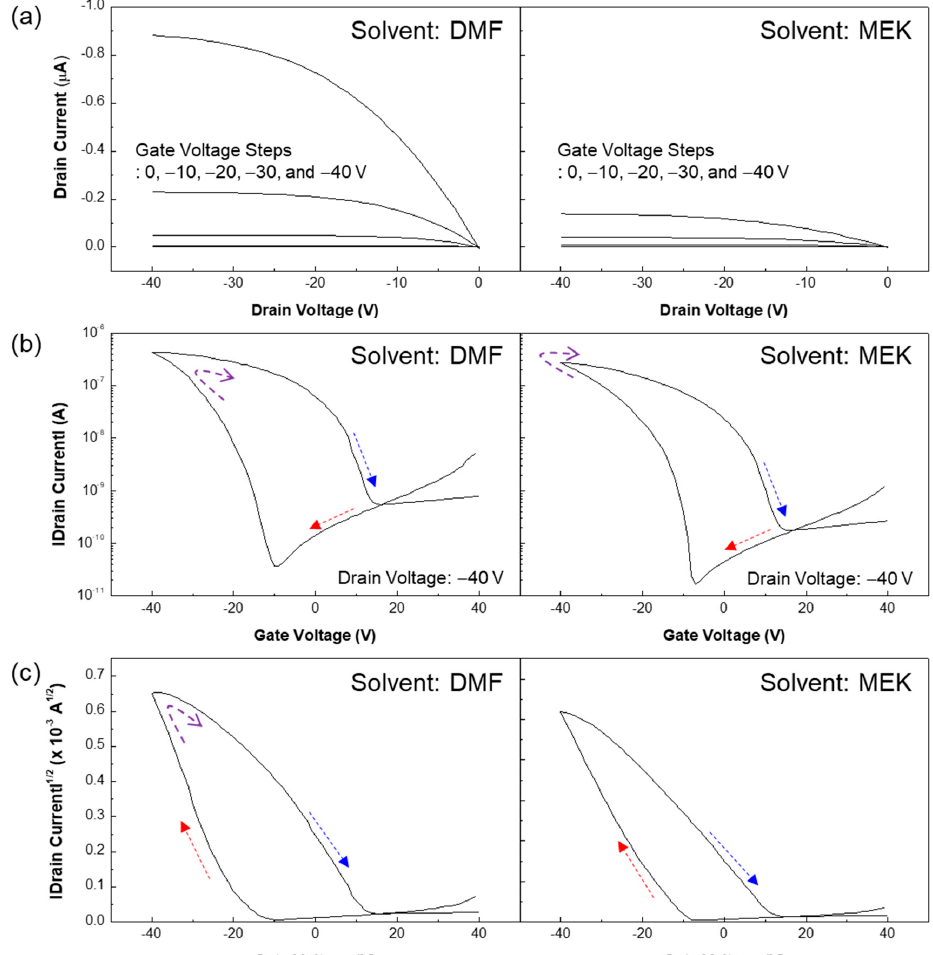
Figure 4. ( a ) Output characteristic curves of flexible Fe-FETs using DMF (left) and MEK (right) solvents; ( b , c ) Transfer characteristic curves (SQRT |drain current| and log |drain current| versus ( b , c ) Transfer characteristic curves (SQRT | drain current | and log | drain current | versus gate voltage, gate voltage, respectively) of flexible Fe-FETs using DMF (left) and MEK (right) solvents. respectively) of flexible Fe-FETs using DMF (left) and MEK (right)